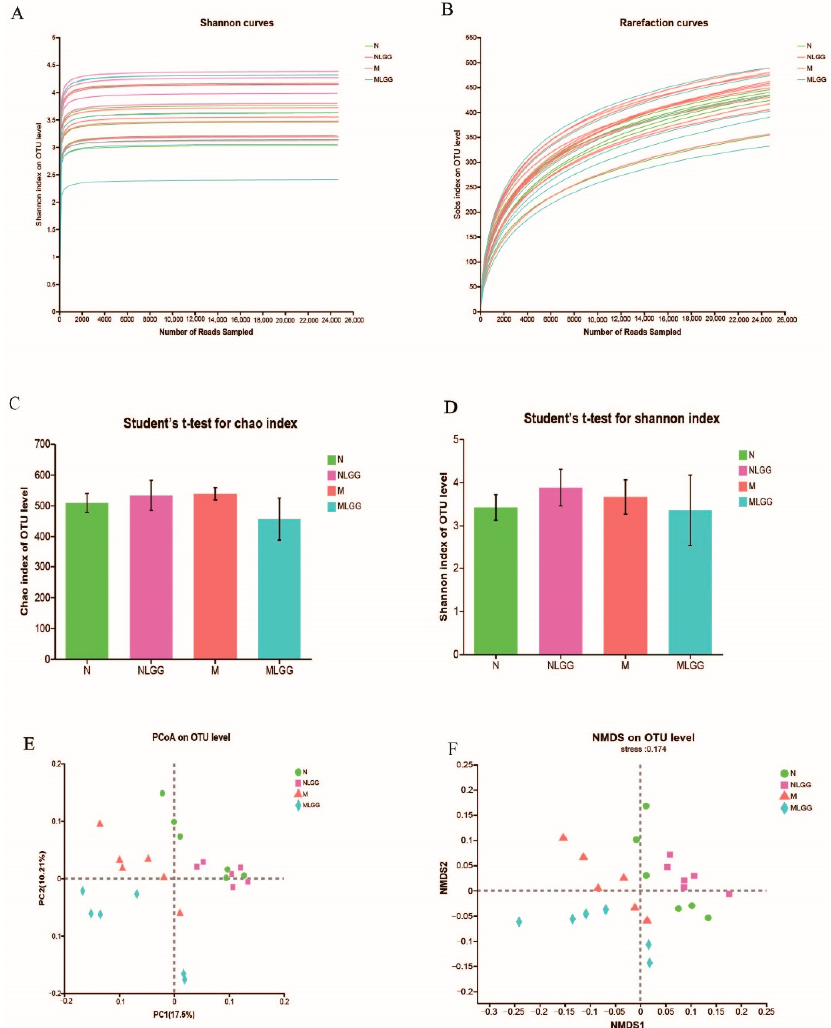
Figure 5. The taxonomic gut microbiota of four groups (control group (N group), control group supplemented with Lactobacillus rhamnosus R0011 ( L. rhamnosus R0011) (NLGG group), liver cirrhosis group (M group), liver cirrhosis group supplemented with L. rhamnosus R0011 (MLGG group)).